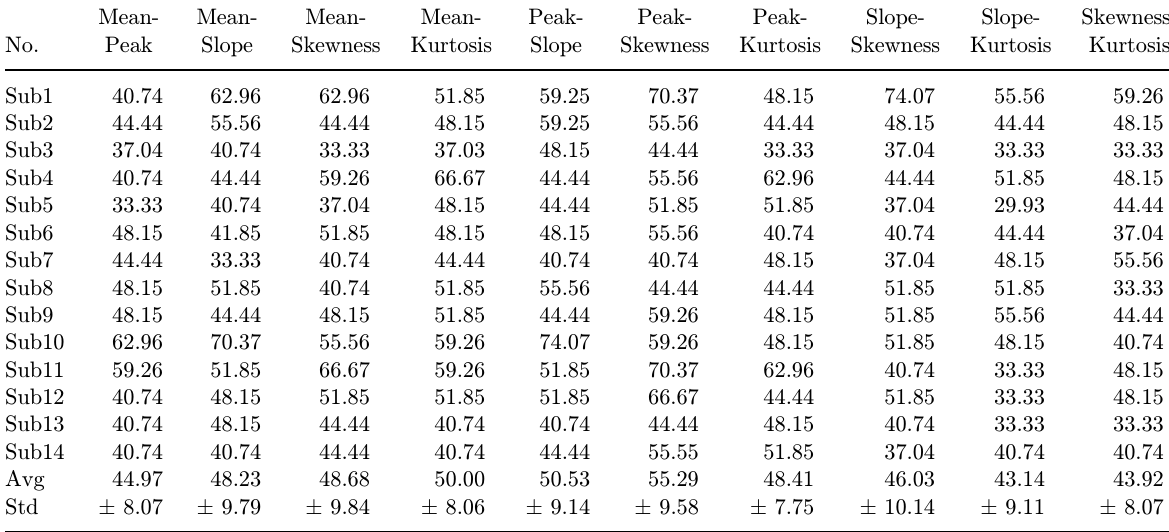
Table 1. Classi¯cation accuracies of 14 subjects and 10 combinations (mean, peak, slope, skewness, and kurtosis).